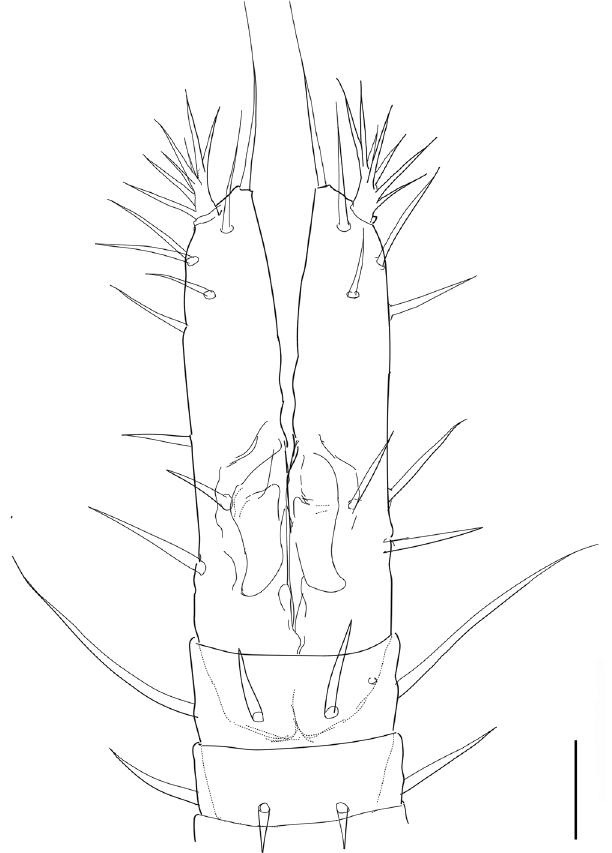
Fig. 7. Siro franzi Karaman & Raspotnig sp. nov., paratype, ♀ (NHMW 28759). Distal portion of ovipositor, ventral view. Scale bar = 50